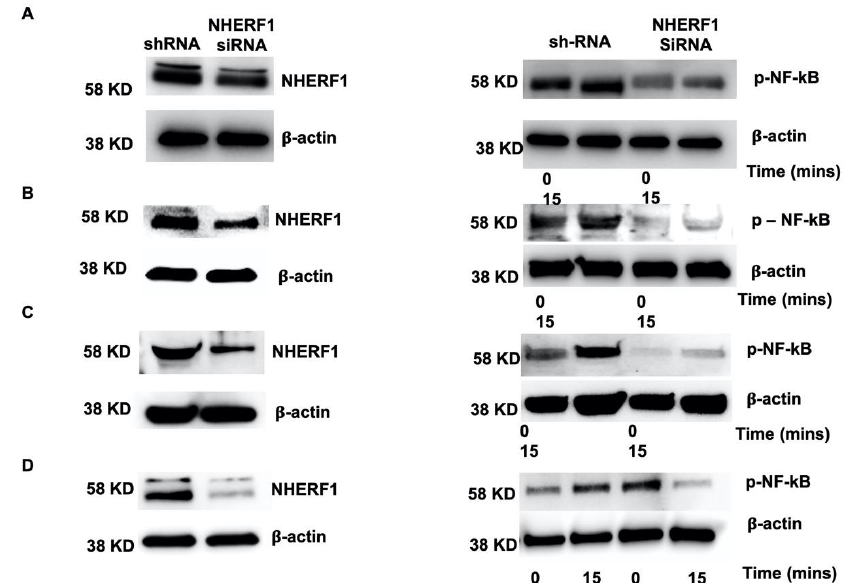
Figure 6. Silencing NHERF1 expression results in decreased p-NF-kB levels. Primary fetal membrane cells ( A ) AECs, ( B ) AMCs, ( C ) CMCs, ( D ) and CTCs were transiently transduced with NHERF1 small interfering RNA (siRNA) and nontargeted siRNA as a control. Representative blots of NHERF1 knockdowns is shown (left column) for respective primary cell type. NF-kB levels following activation with LPS for 15 min is shown in the right column. Representative blots for four different types of primary cells from three independent experiments are shown. The blots with NHERF1 and p-NF-kB were stripped and reprobed with the β-actin antibody for loading control. Int. J. Mol. Sci. 2020 , 21 , x FOR PEER REVIEW